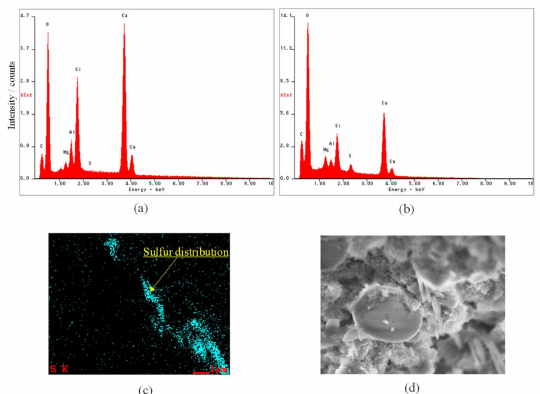
Figure 10. Elemental analysis results of glass fibers before and after SO 2 adsorption tests. ( a ) Spectral profile before SO 2 adsorption test, ( b ) Spectral profile after SO 2 adsorption test, ( c ) An image of sulfur elemental mapping by EDS, ( d ) SEM image of mapping